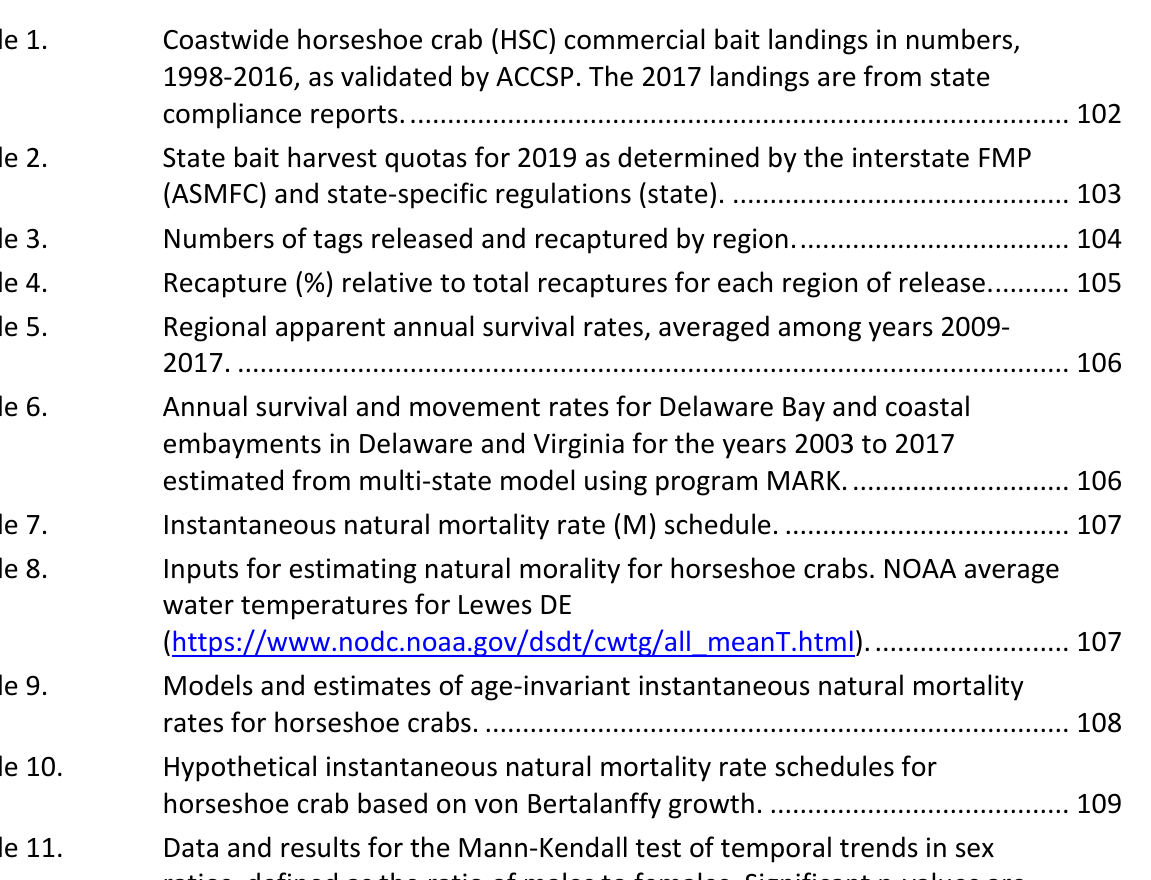
Regional apparent annual survival rates, averaged among years 2009- Annual survival and movement rates for Delaware Bay and coastal embayments in Delaware and Virginia for the years 2003 to 2017